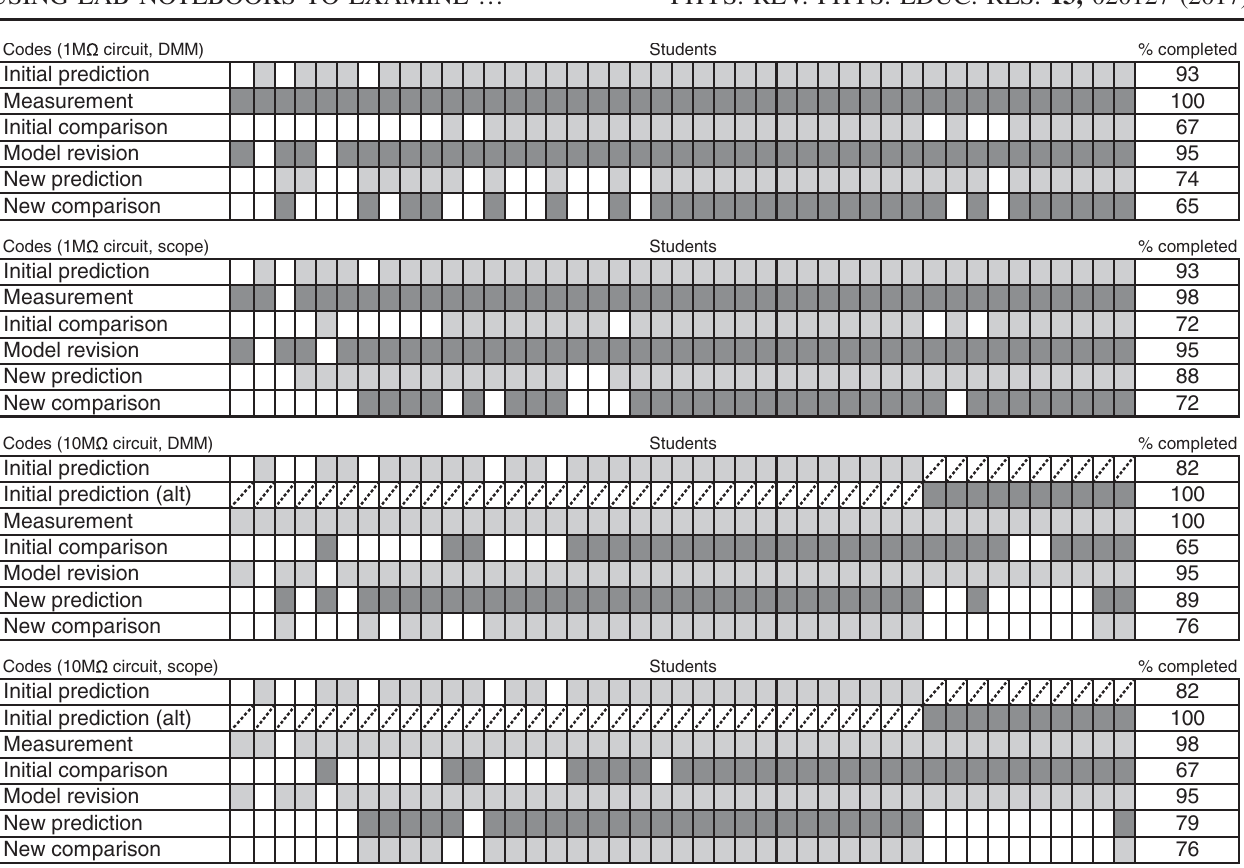
(cid:129) Quantitative: Students made an evaluation of the comparison based on a percentage error criteria that the class. (cid:129) Qualitative: Students made a subjective comparison